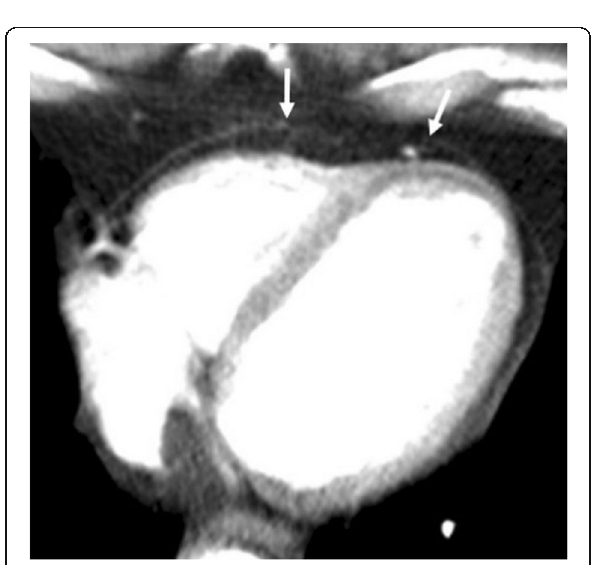
Fig. 2 A 68-year-old man with previous coronary artery bypass surgery. Axial contrast-enhanced CT image demonstrates the lack of pericardial continuity (arrows) due to